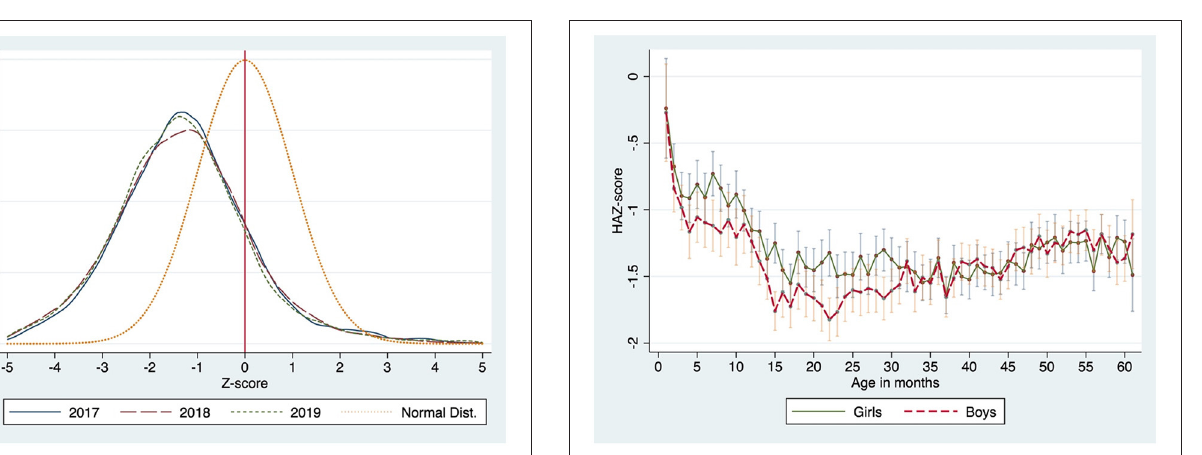
Pattern of Wasting In 2019, wasting prevalence peaks at the first month of age and then it decreases with increasing age up to 24 months of age (shown in Figure 6 ). At the age of 24 months the wasting prevalence stabilizes around 10%. Severe wasting prevalence shows a similar pattern but with a less sharp trend. Table 3 shows the wasting information. Ninety-five percent confidence intervals (95% CI) show that the wasting prevalence among boys is not statistically higher than their female counterparts. Wasting prevalence decreased significantly over the period of analysis (2017–2019), from about 15% in 2017 to 11.5% in 2019. Regarding the distribution of the WHZ score over age